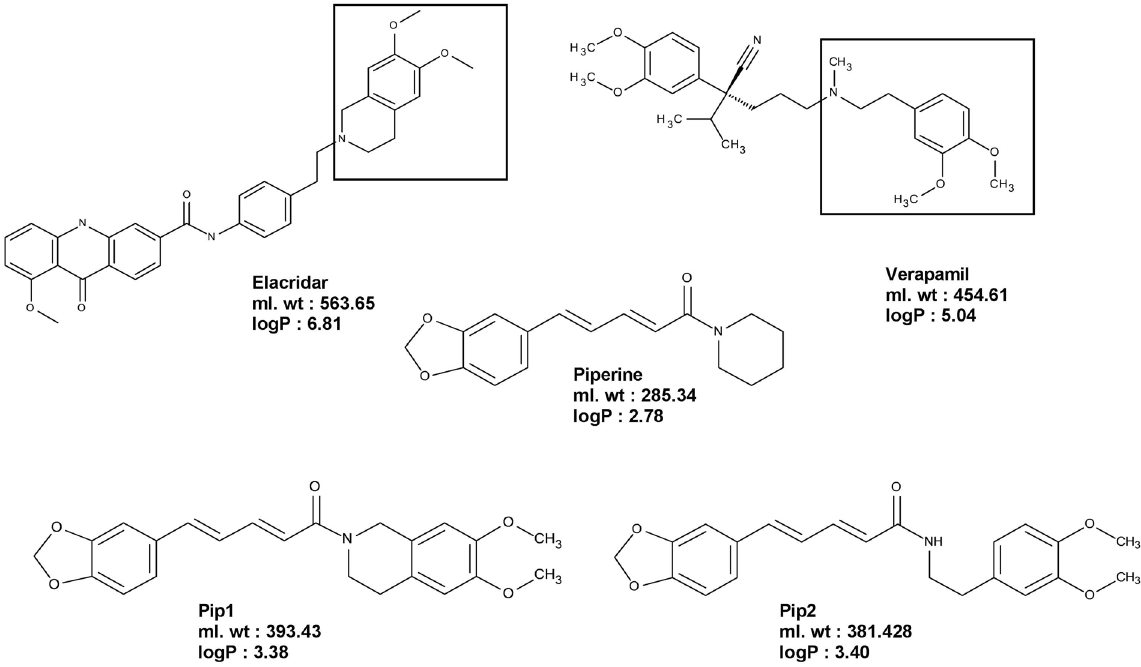
Figure 1. Conceptual design of piperine analogs – Pip1 and Pip2 – as P-gp inhibitors.